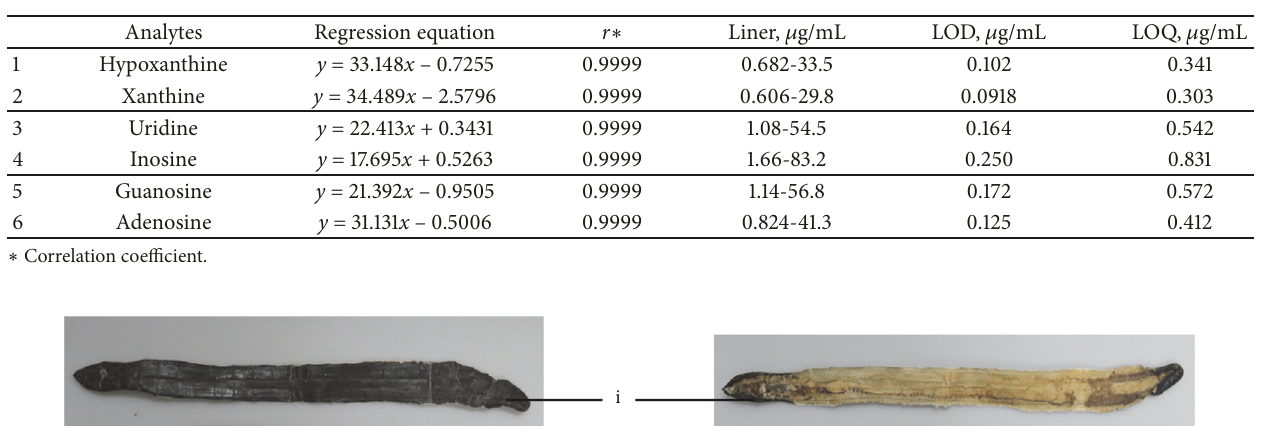
Table 2: Regression equations, correlation coefficients, linear ranges, and LOD and LOQ of six target analytes.